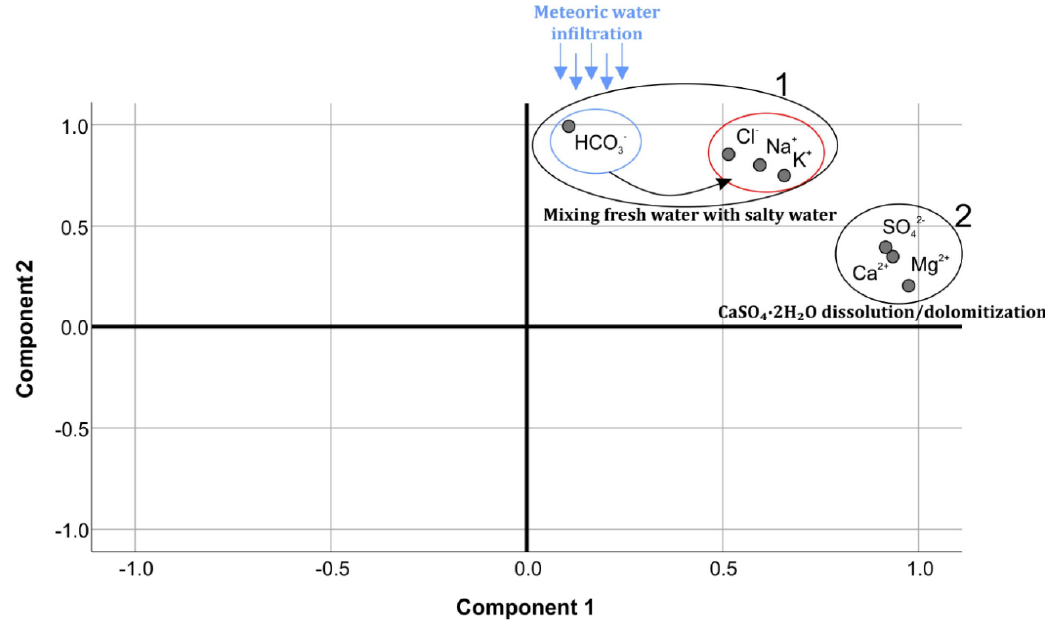
Figure 9. Components plot in rotated space.